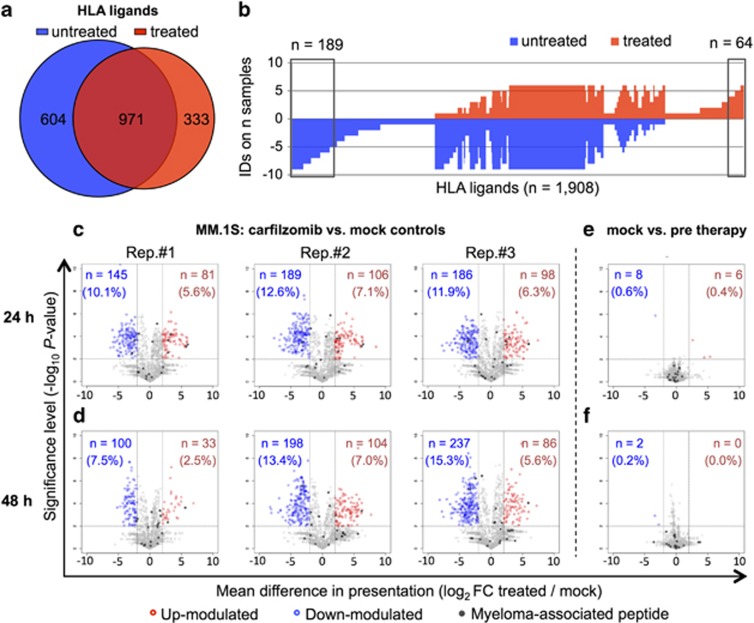
Carfilzomib induces substantial qualitative and quantitative changes in the HLA ligandome of MM.1S cells. (a) Overlap analysis of HLA class I ligands identified on carfilzomib-treated versus untreated (mock controls and pre-therapy) cells. (b) Frequency-based analysis of peptide presentation on treated versus untreated MM.1S cells. HLA ligands are indicated on the x axis and the numbers of samples on which they were detected on the y axis. The box on the right highlights HLA ligands showing significant treatment-associated presentation (exclusive presentation on ⩾4/6 treated samples, FDR=3.0%), whereas the box on the left indicates peptides lost after carfilzomib therapy (exclusive presentation on ⩾5/9 untreated samples, FDR=4.9%). (c–f) Volcano plots of modulations in the relative abundances of HLA ligands on MM.1S cells comparing the conditions indicated. Each dot represents a specific HLA ligand. Log2-fold changes of their abundance are indicated on the x axis and the corresponding significance levels after Benjamini–Hochberg correction on the y axis. HLA ligands showing significant up- or down-modulation (>4-fold change in abundance with P<0.01) are highlighted in red and blue, respectively. The numbers and percentages of these significantly modulated ligands are specified in the corresponding quadrants. (c, d) Volcano plots comparing HLA ligand abundances on carfilzomib versus mock-treated cells at t24h and t48h, respectively. (e, f) Control volcano plots comparing HLA ligand abundances on mock-treated cells at t24h and t48h to baseline levels before therapy.